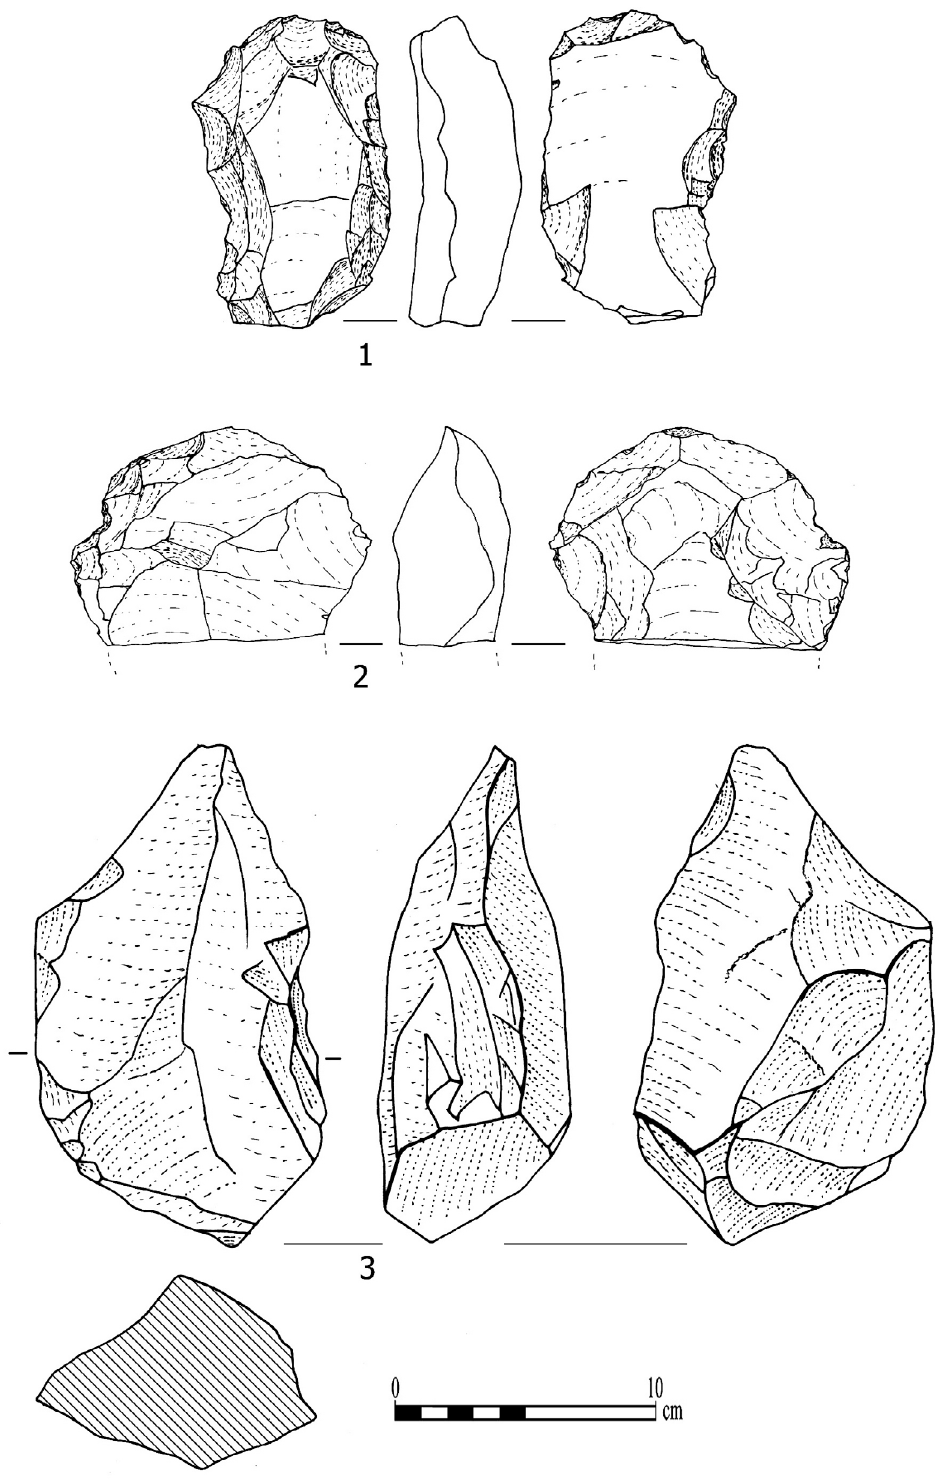
Figure 8. Basanite rough-outs from Locus